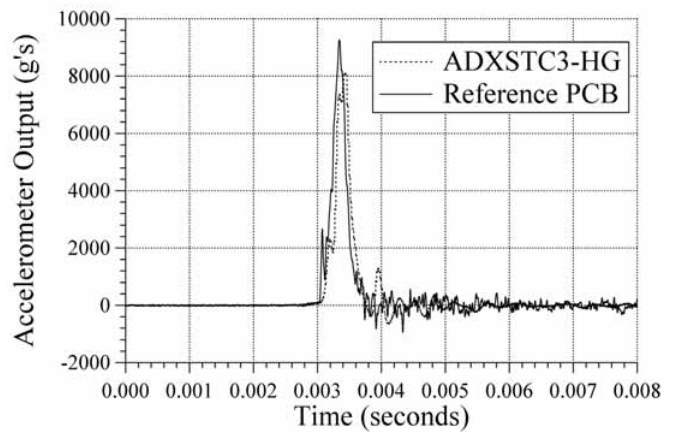
Fig. 7. Shock acceleration vs. time.